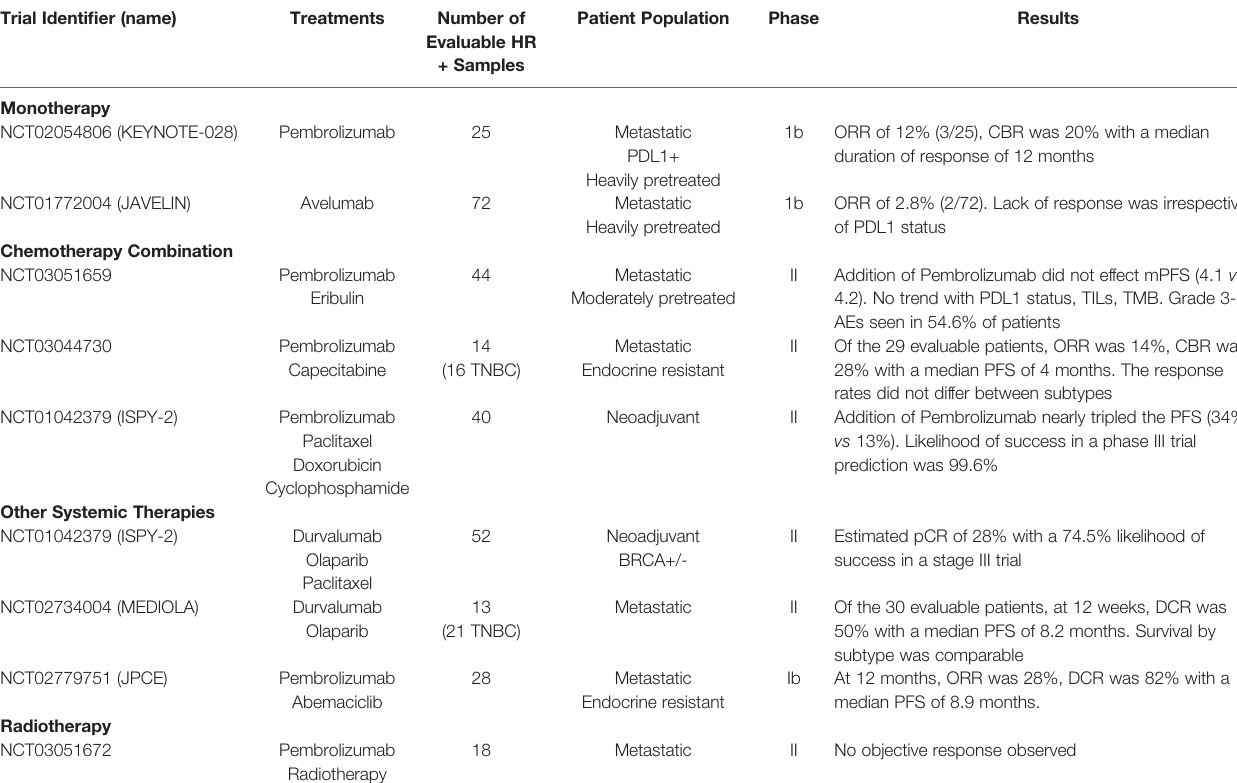
TABLE 2 | Clinical trials in HR+ breast cancer assessing the safety and ef fi cacy of ICB as monotherapy or in combination with chemotherapy and other treatment modalities. Trial Identi fi er